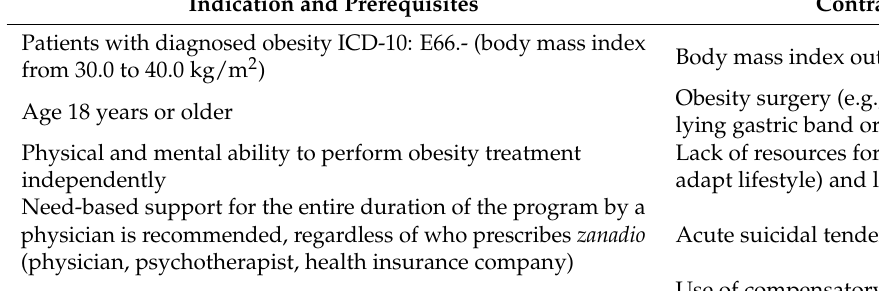
Table 1. Indication and prerequisites, contraindications and exclusion criteria for using the app zanadio . Indication and